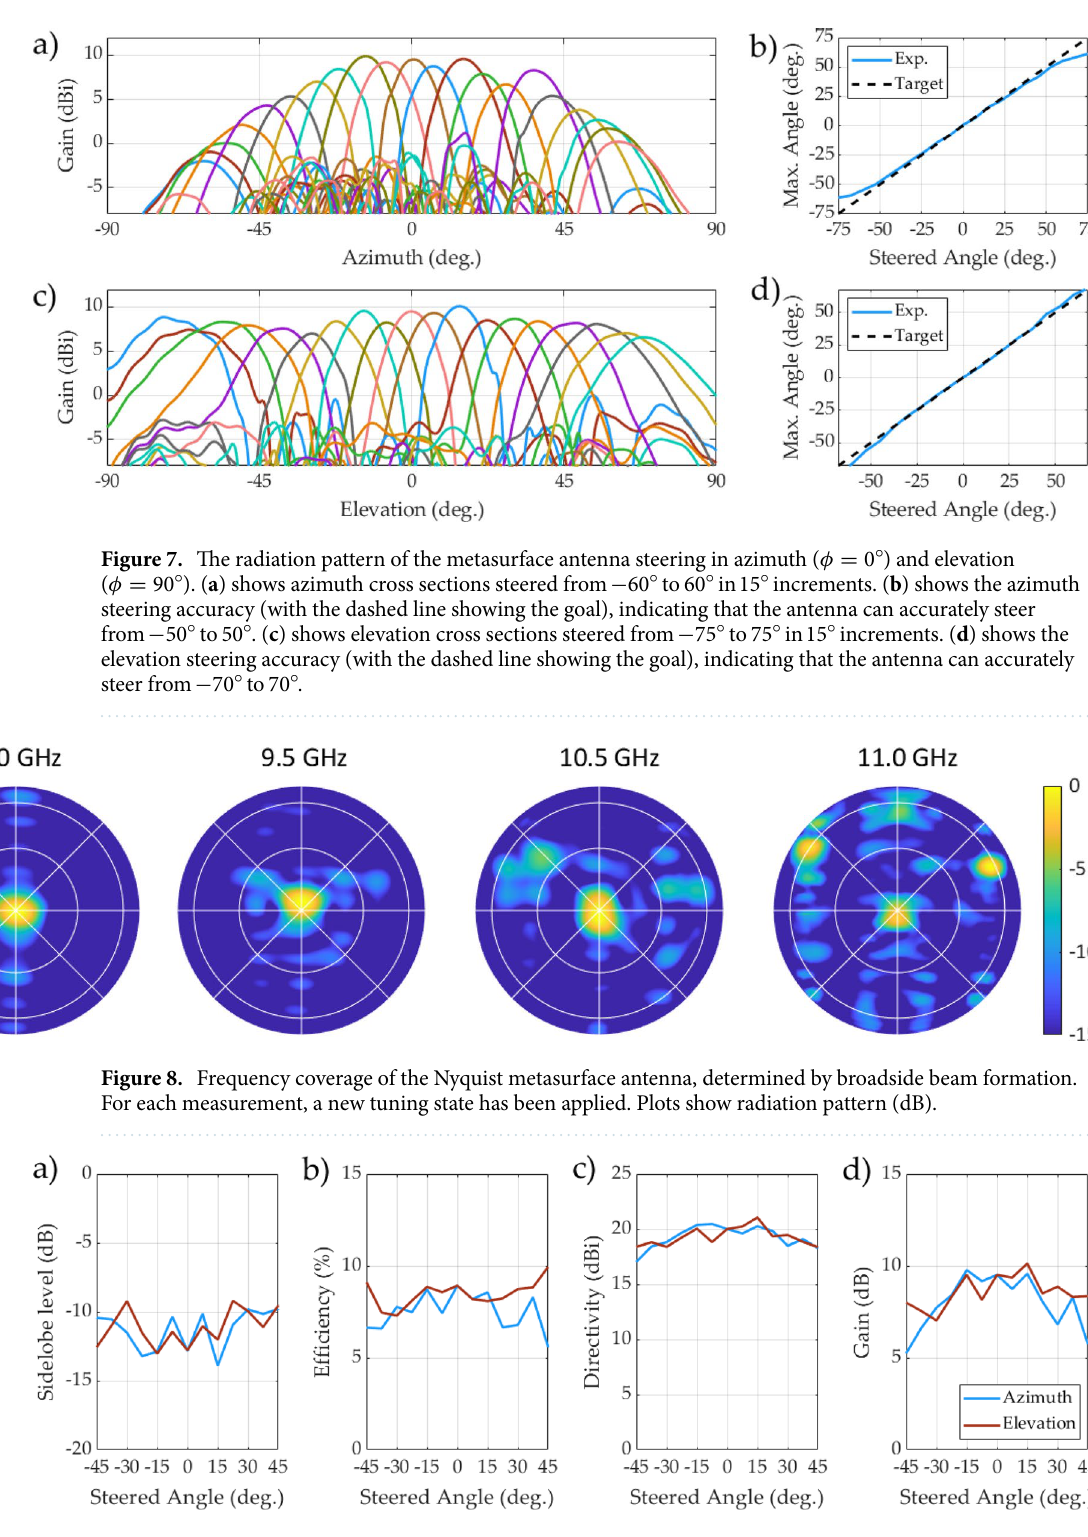
Figure 9. Antenna metrics as a function of azimuth and elevation